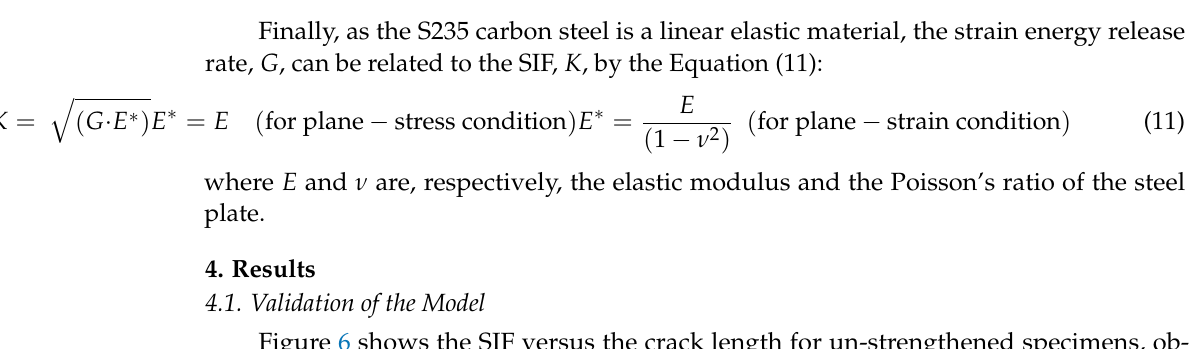
Figure 6. SIF (Stress Intensity Factor) versus crack length for un-strengthened specimens.